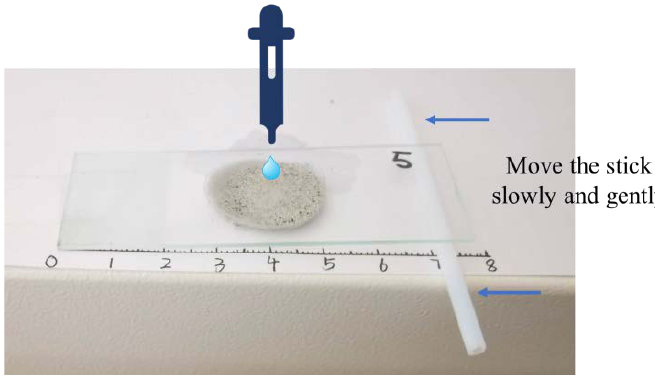
Figure 2. The test method for the sliding angle of the surface coating.